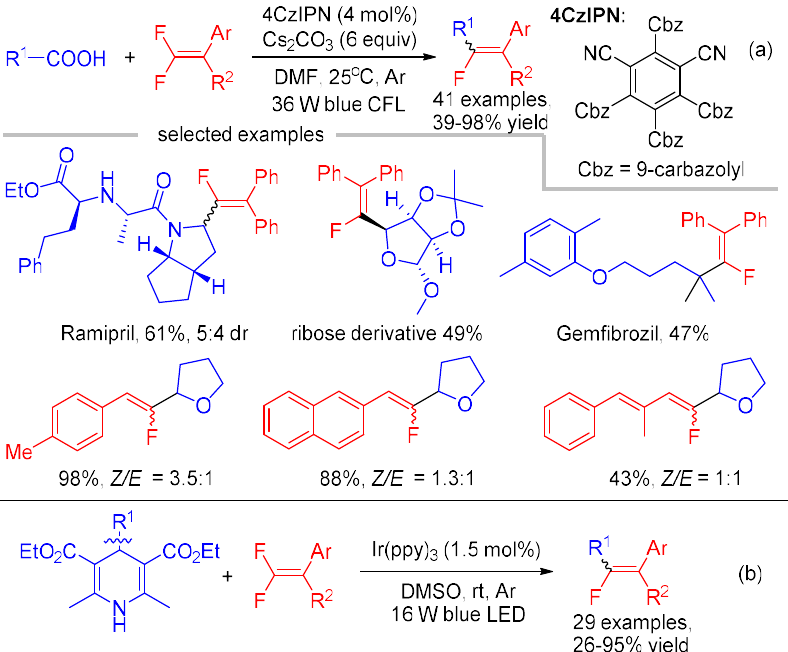
Scheme 13. Defluorinative alkylation of gem -difluoroalkenes: ( a ) alkyl carboxylic acids as the radical precursors; ( b ) 4-alkyl-1,4-dihydropyridines as the radical precursors. The cross-coupling of monofluoroalkenyl radicals and alkyl radicals can be inter- rupted by adding another reaction component. Wang disclosed the visible-light-induced trifluoromethylation and monofluoroalkenylation of alkenes through three-component